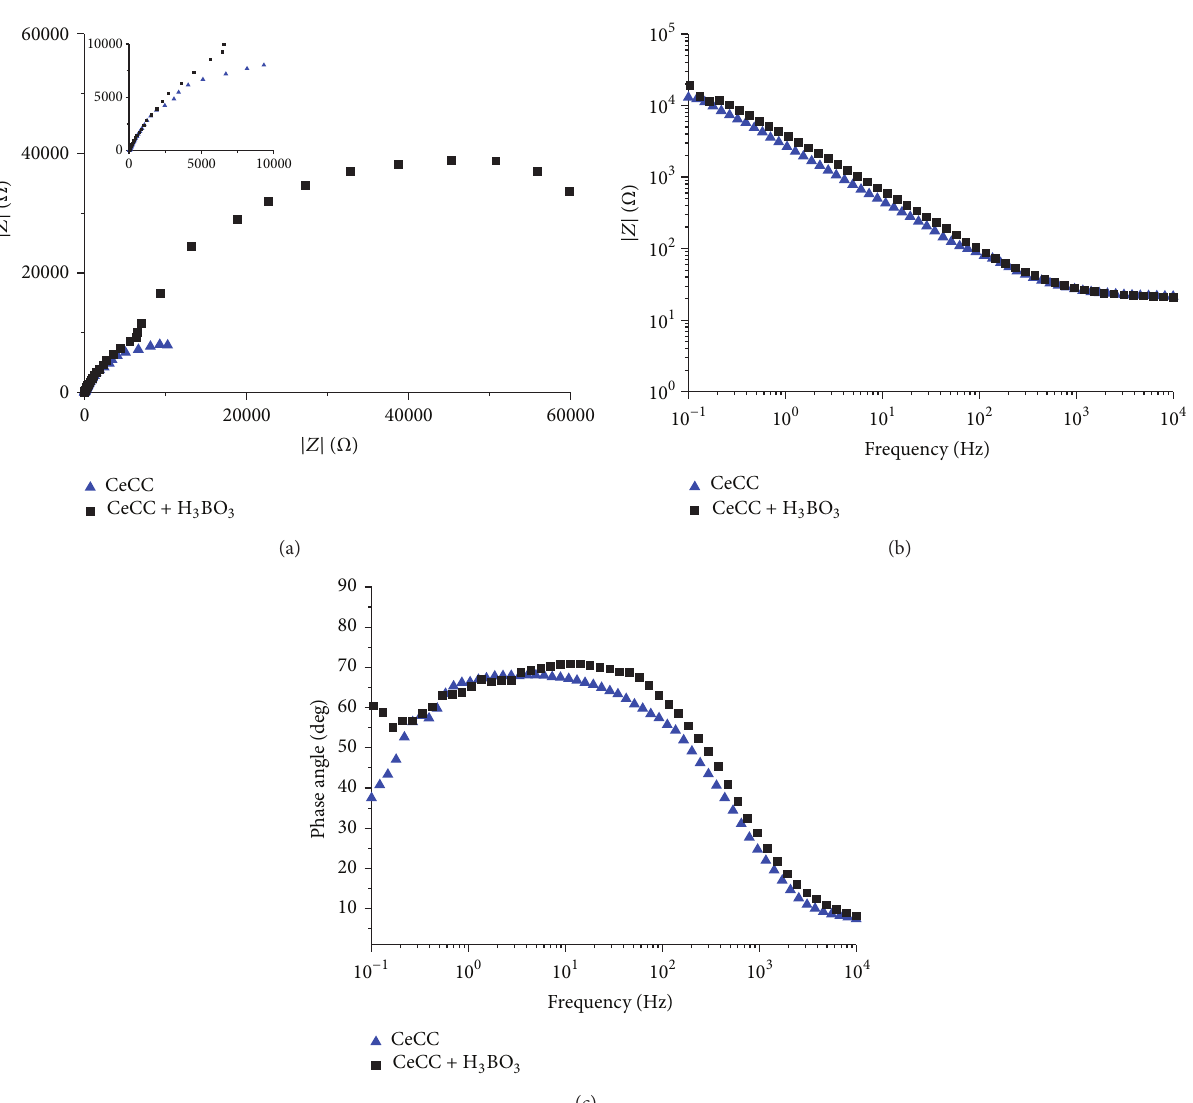
Figure 5: Nyquist and zoom of Nyquist (a) and Bode ((b)-(c)) impedance plots for treated and untreated aluminium samples in a 3.5% wt NaCl aqueous